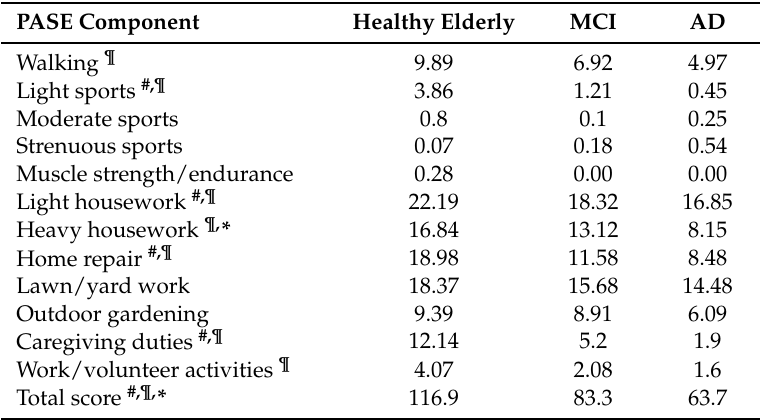
Table 2. PASE components by